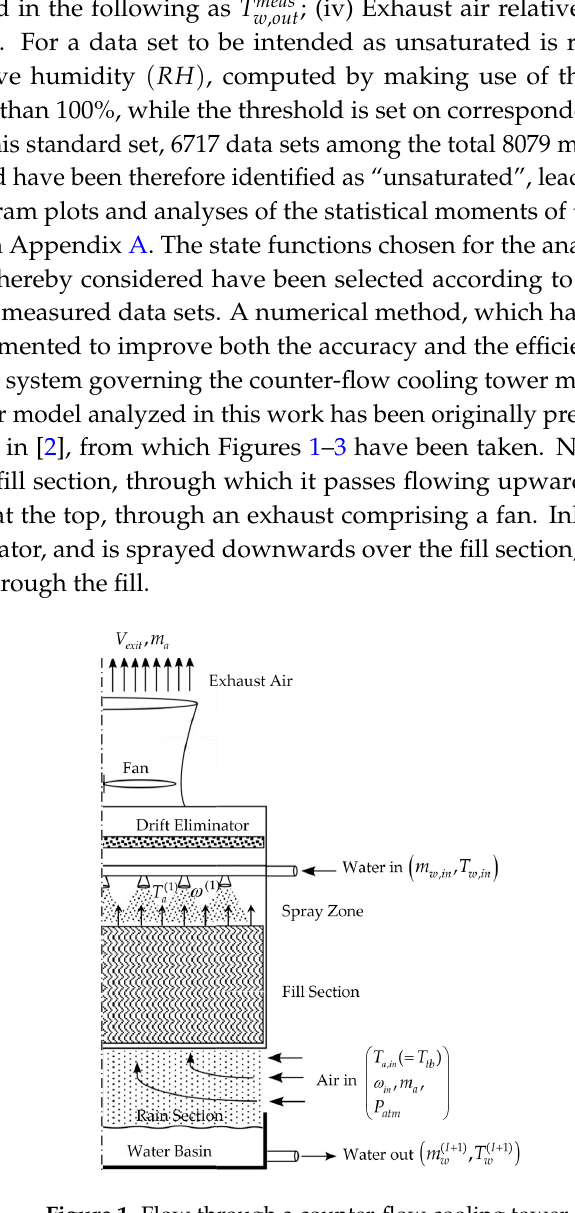
Figure 1. Flow through a counter-flow cooling tower.